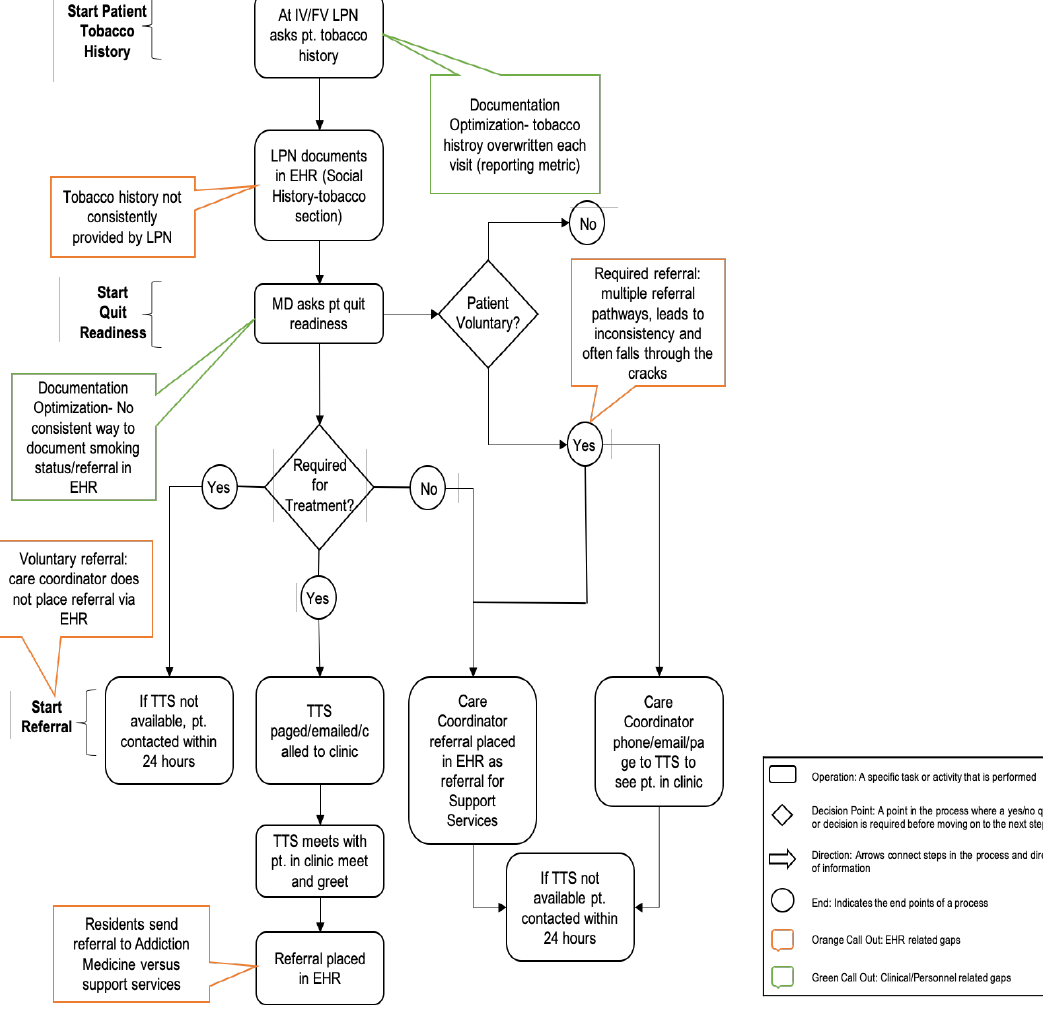
Figure 1. Snapshot of Value Stream Map. IV = initial visit, FV = follow-up visit, LPN = licensed practical nurse, pt = patient, MD = physician, TTS = Tobacco treatment Specialist, EHR = Electronic Health Record.